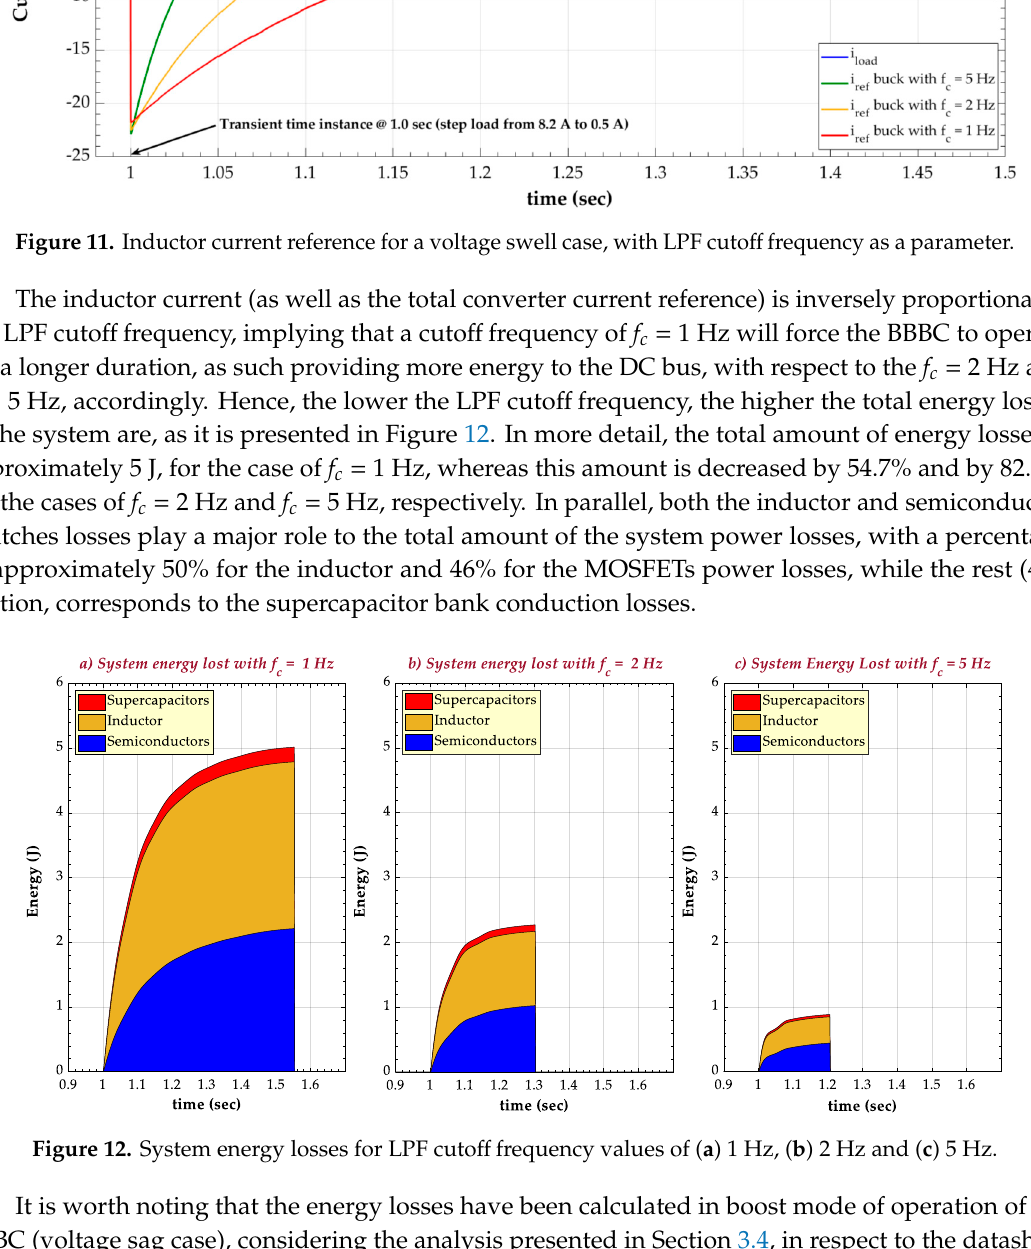
Figure 11. Inductor current reference for a voltage swell case, with LPF cutoff frequency as a parameter.